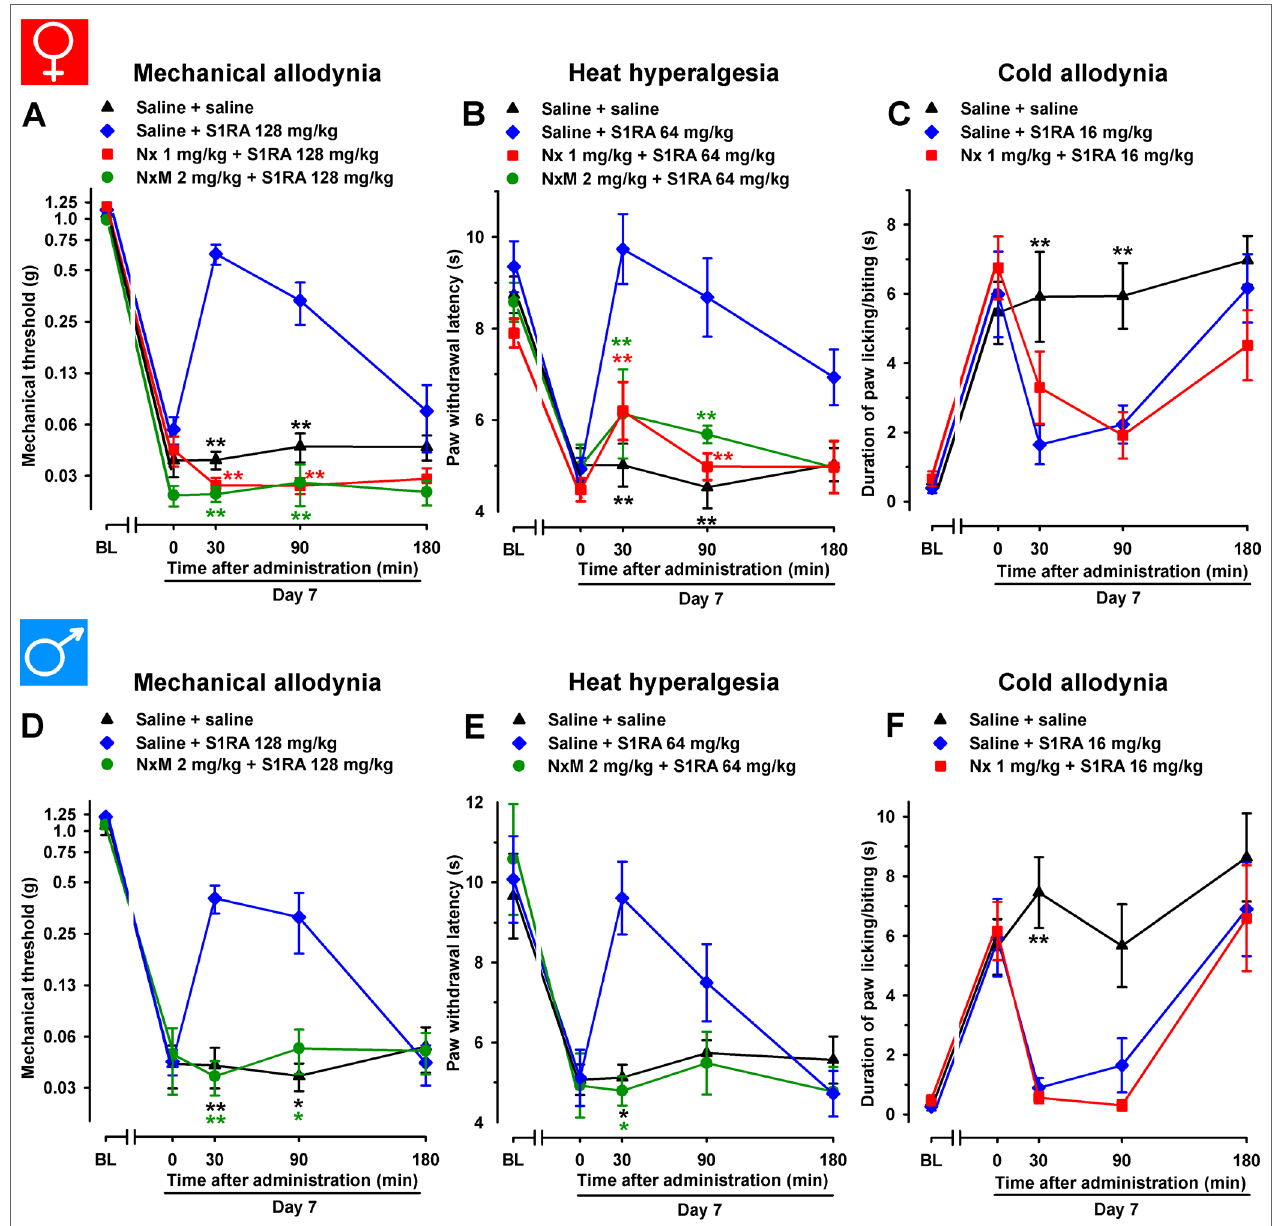
FIGURE 6 | The opioid antagonists naloxone hydrochloride (Nx) and naloxone methiodide (NxM) reversed the effects of S1RA on mechanical allodynia and heat hyperalgesia but not on cold allodynia in female and male WT mice with SNI 7 days after surgery. In female mice, mechanical allodynia (A) , heat hyperalgesia (B) , and cold allodynia (C) were evaluated 1 day before (baseline, BL) and 7 days (day 7) after surgery. Identical procedures were performed on male mice for the determination of mechanical (D) , heat (E) , and cold (F) sensitivity. On day 7 the responses to test stimuli in the paw ipsilateral to the surgery were recorded immediately before (time 0) and at several times (30, 90, and 180 min) after injections of the drugs (S1RA and opioid antagonists) or saline. Each point and vertical line represent the mean ± SEM of the values obtained in 8–14 animals. Statistically significant differences in comparison to the saline+S1RA group: ** P < 0.01 (two-way repeated-measures ANOVA followed by Bonferroni